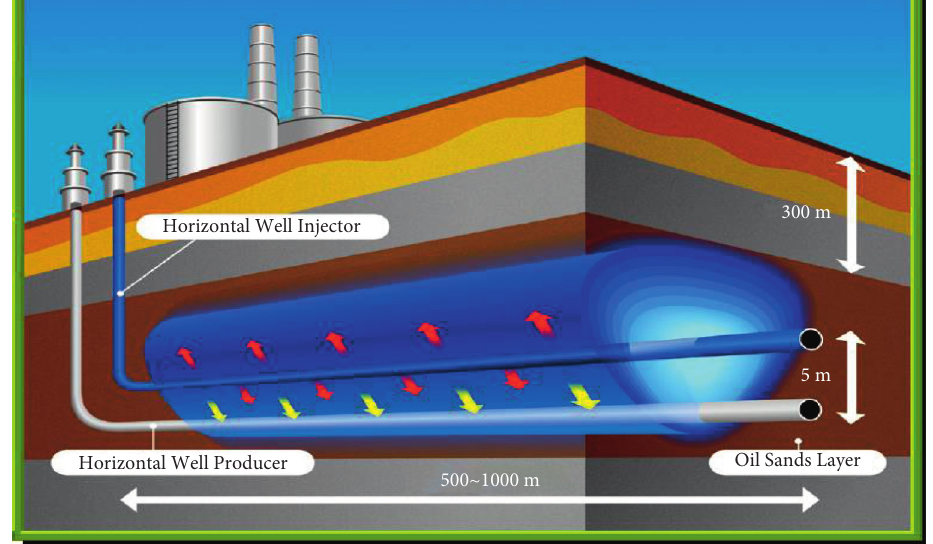
Figure 2: Schematic diagram of the SAGD oil production mechanism and basic well pattern form.